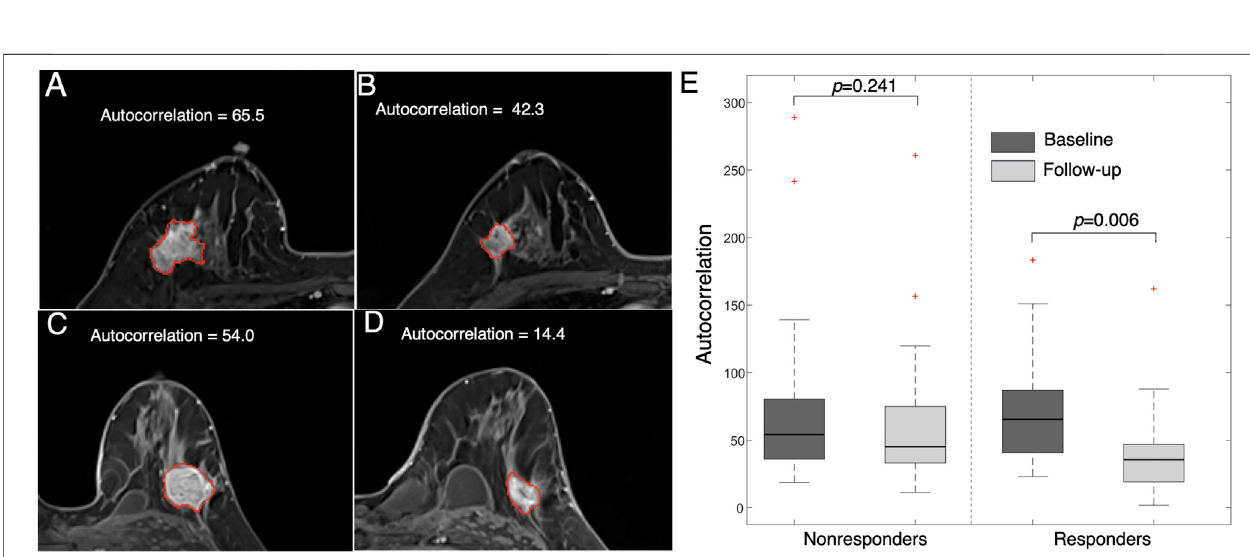
FIGURE 5 | Feature (energy) change between baseline and early NACT images. Images from a 58 year-old woman with a deltaRAD value of 0.876 in the responders at (A) baseline and (B) early NACT. Images from a 49 year-old woman with a deltaRAD value of 0.618 in the nonresponders at (C) baseline and (D) early NACT. (E) Thedistributionofthechangeintheenergyvalueisshownintheboxplot,inwhichthefeaturevalueissigni fi cantlyhigherinrespondersthaninnonresponders.